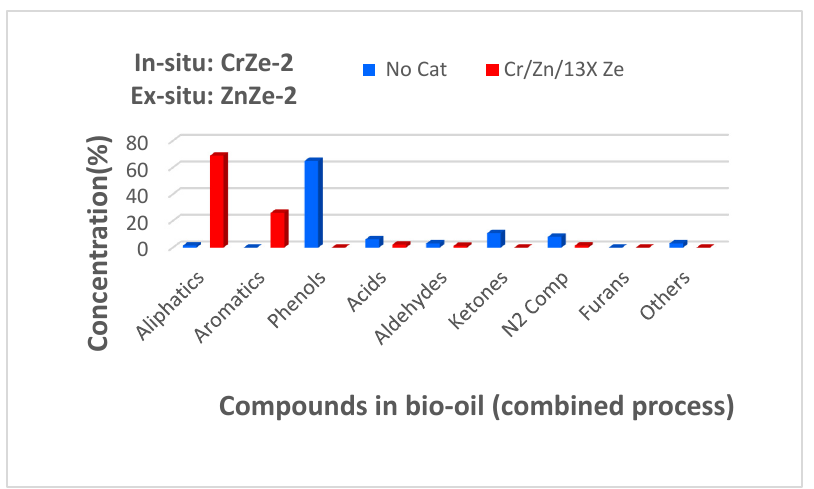
Figure 10. Bio-oil composition resulted by combined in situ and ex situ pyrolysis of PTCCB; catalyst- to-biomass ratio was 2 (see Table 1).